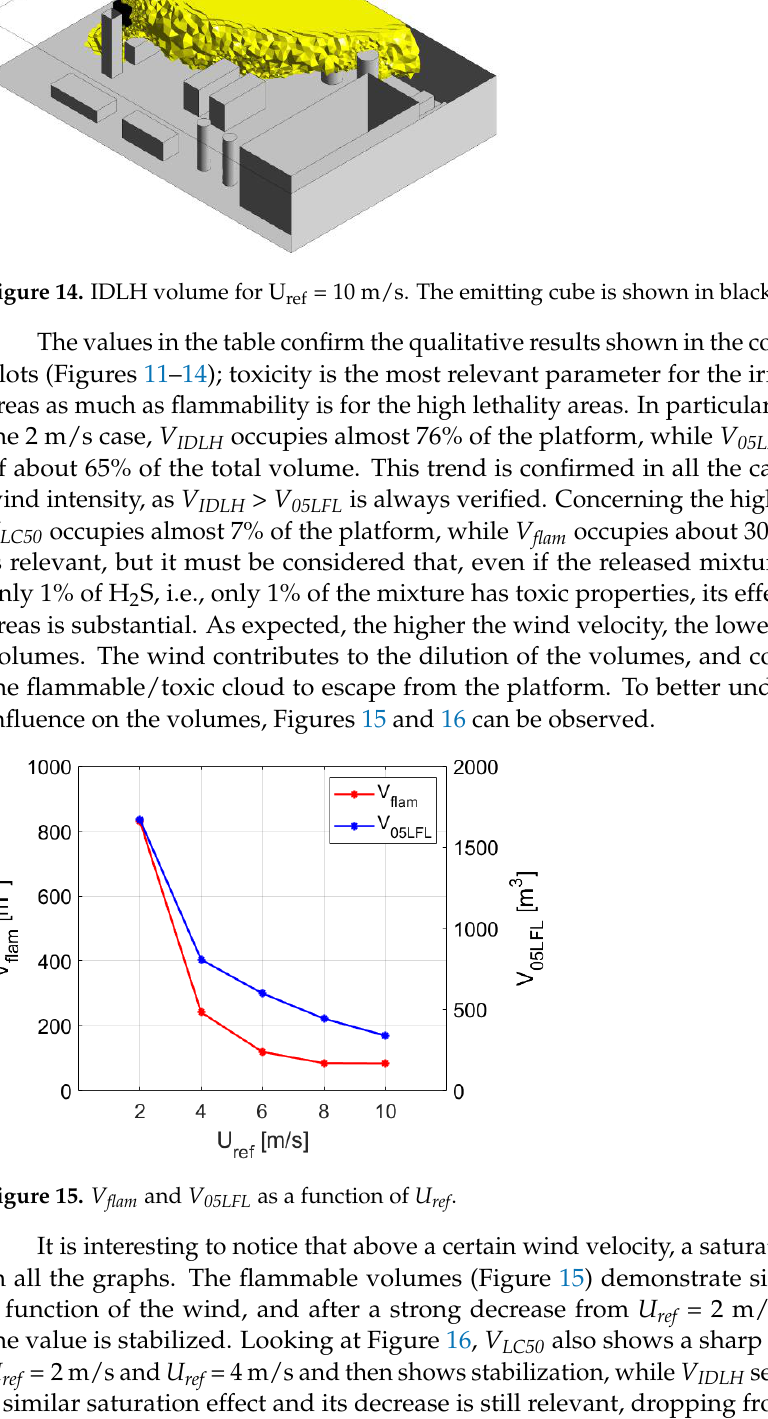
Figure 13. The 0.5LFL volume for U ref = 10 m/s. The emitting cube is shown in black.